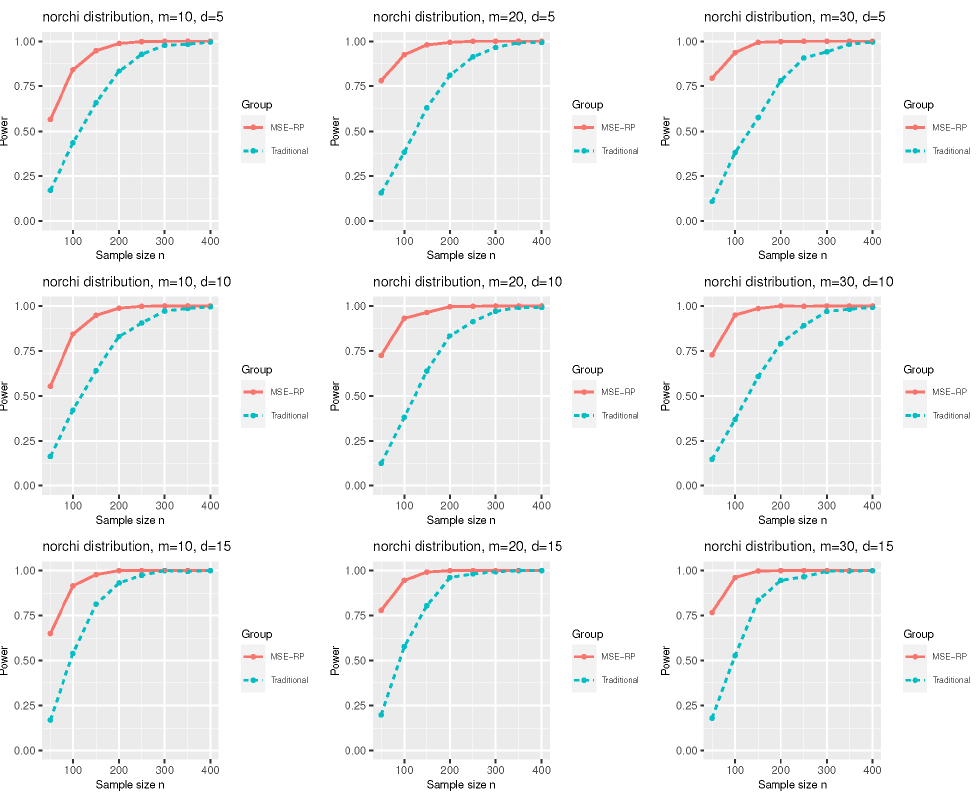
Figure 3. Power ( α = 0.05) in distribution N ( 0,1 ) + χ 2 ( 2 )